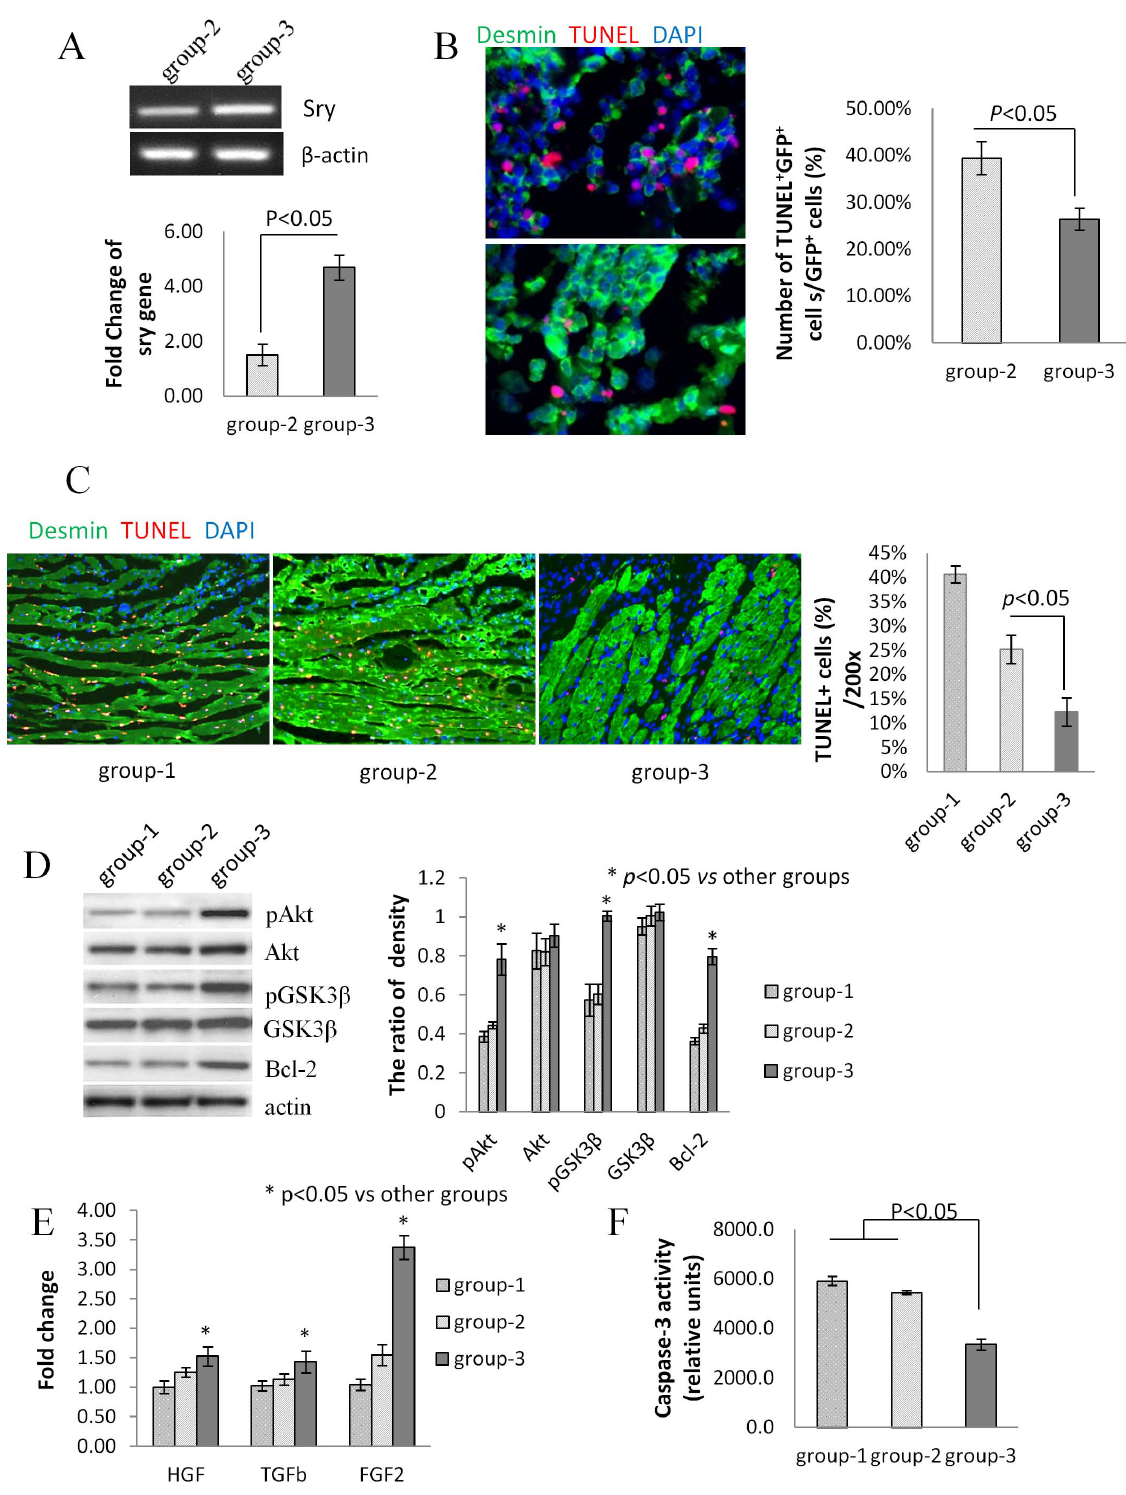
Figure 5. Cardioprotective effects of transduced PKG1 a in vivo. (A) Real-time PCR for sry gene in female rat heart model of acute myocardial infarction at 7 days after sex-mismatched transplantation of Null MSCs (group-2) and PKG1 a MSCs (group-3). Cell survival was significantly higher in PKG1 a MSCs as compared with the Null MSCs group (n=4/group). (B) TUNEL and GFP double staining on histological sections of rat heart tissue injected with Null MSCs (group-2) and PKG1 a MSCs (group-3). The number of apoptotic transplanted MSCs (TUNEL + GFP + , red and green) was significantly reduced in group-3 ( p , 0.05 vs group-2). (C) TUNEL(red) combined with desmin immunostaining (green) on histological sections showed less apoptosis in residual myocardium in group-3 compared to group-1 and group-2 ( p , 0.05). (D) Western blot on protein lysate samples of the rat left ventricle showed increased phosphorylation of Akt,GSK3 b , and high level of Bcl-2 expression at 3 days after transplantation in group-3 (p , 0.05, n=4/ group). (E) Real-time PCR for growth factors expression showed HGF, TGF b and FGF2 were significantly increased in left ventricle tissue at 3 days after transplantation. (F) Diminished caspase-3 activity was detected in heart tissues in group-3. doi:10.1371/journal.pone.0060087.g005 PLOS ONE |